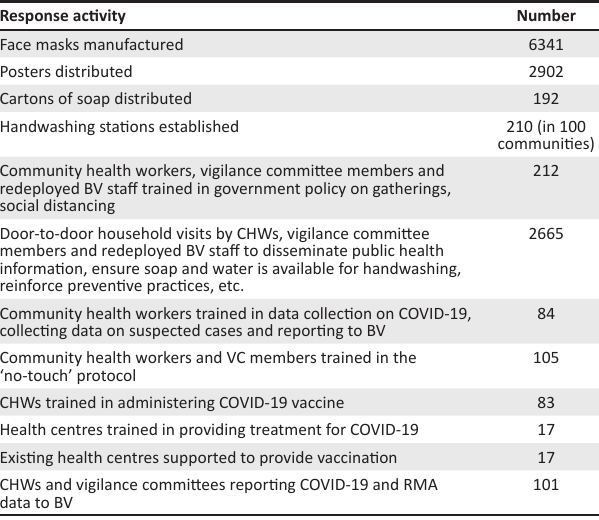
TABLE 2: Activities implemented in response to COVID-19 at Blue Ventures sites in Madagascar (in 2020). Response activity